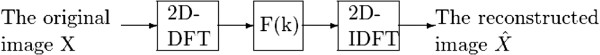
The flow Chart with the filtering process to improve the performance of CT reconstruction.